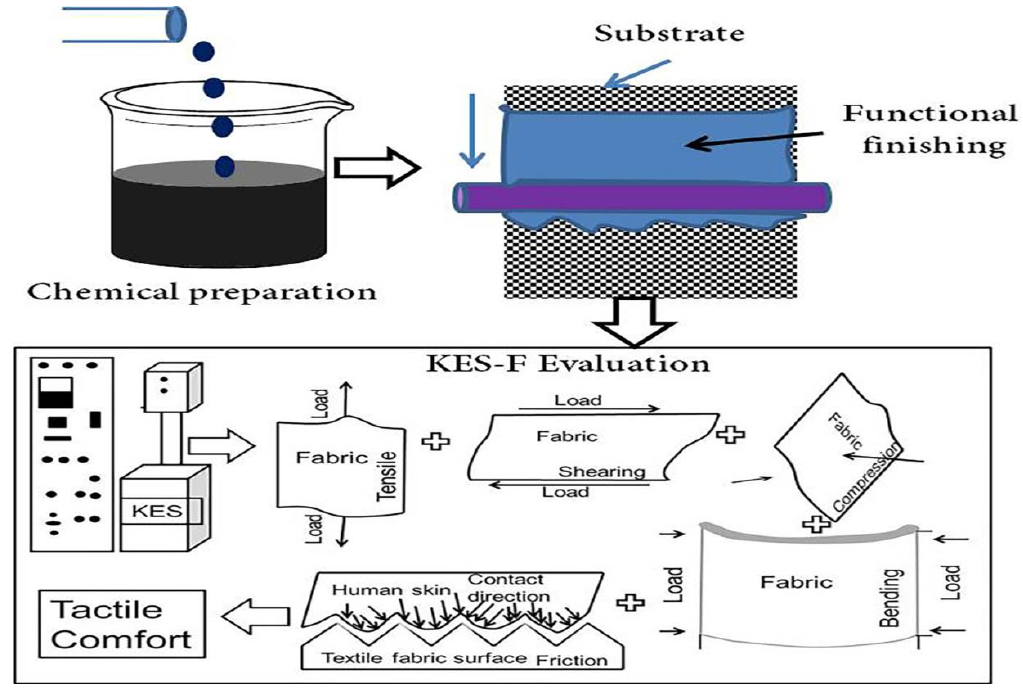
Figure 1. Chart which shows the low-stress mechanical properties measurement principle and process flow in relation to the tactile properties of the functional fabrics.